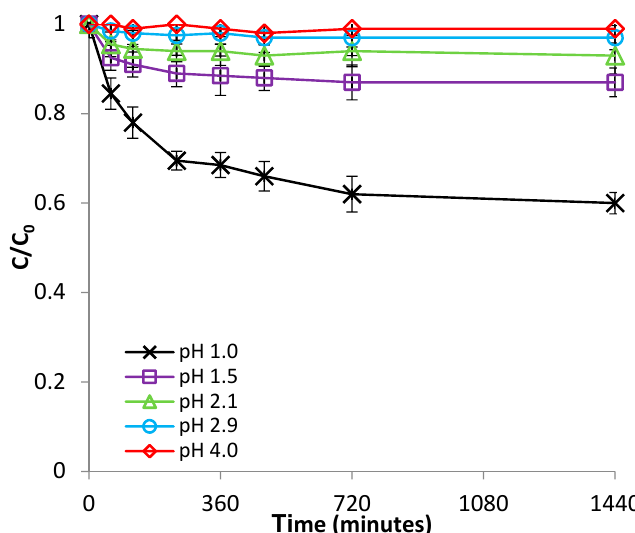
Figure 6. Effect of pH on Cr(VI) removal by bentonite.